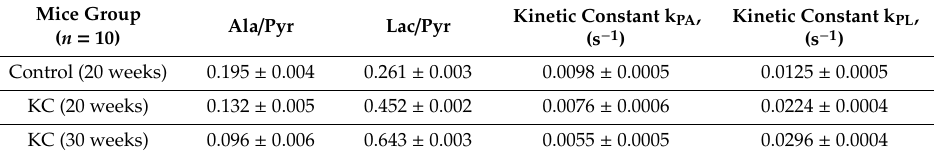
Table 1. Real-time in vivo metabolic flux data obtained by HP-MRS.